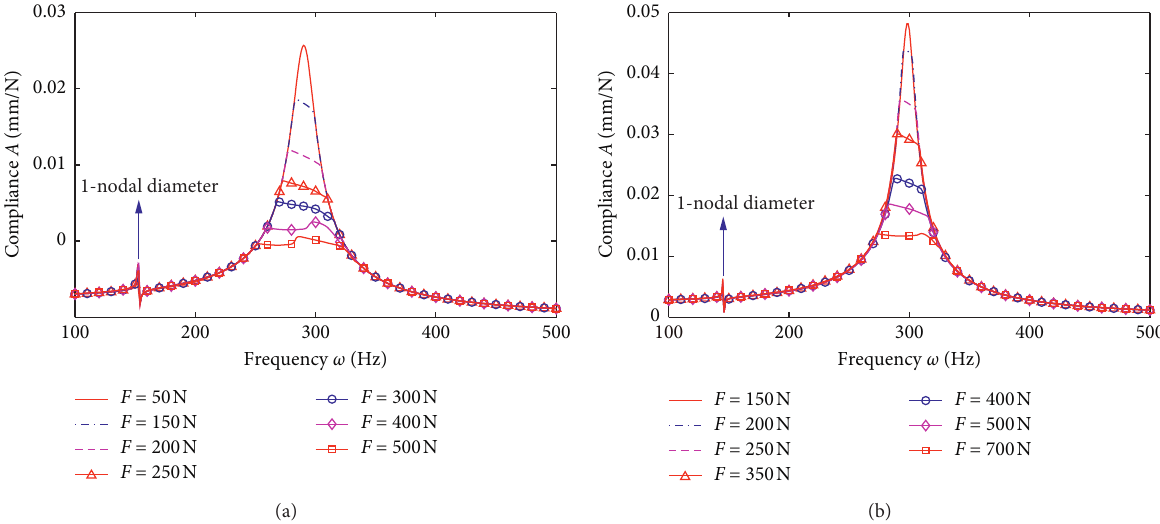
Figure 12: The compliance of beam 1 for different excitation levels F : (a) Ω � 200rad/s and (b) Ω � 300rad/s. −1−0.500.51